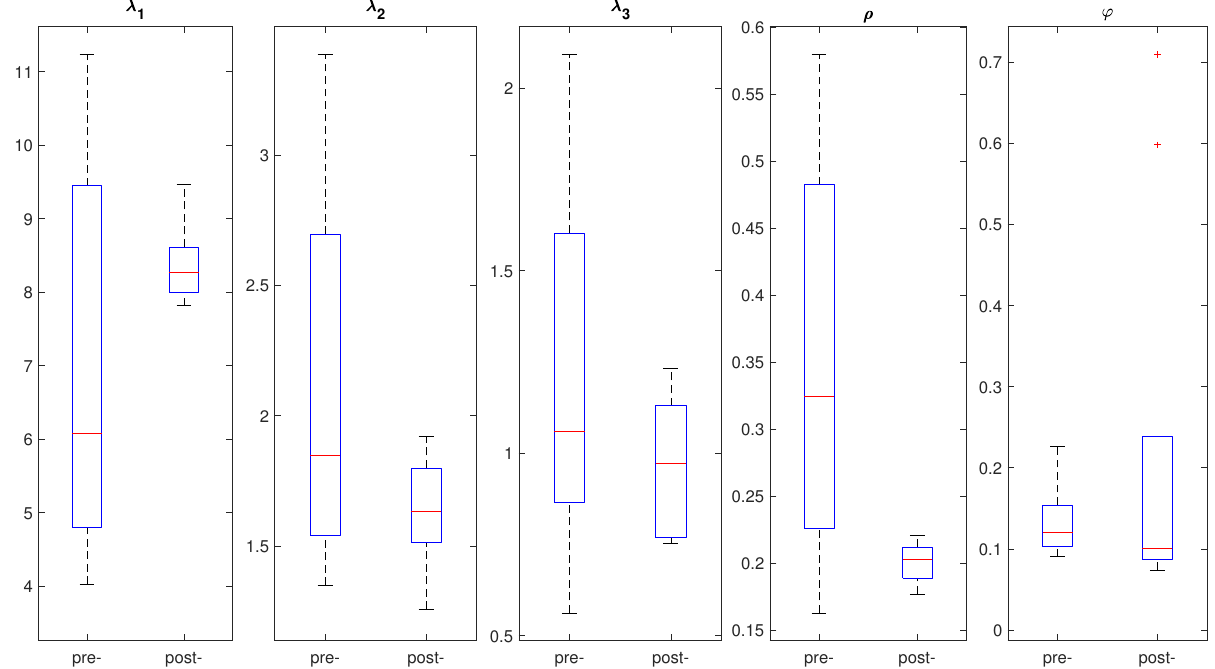
Figure 2. Example of box plots for different morphological features of P-wave loops under study comparing pre- and post-PVI distribution for a patient included in the study.